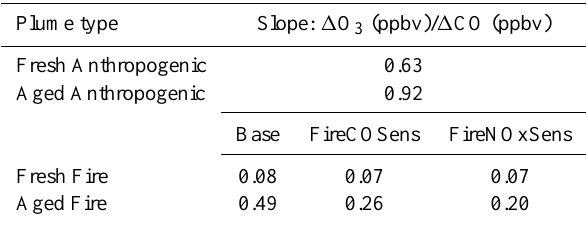
Fig. 13. The average increase in ozone ( 1 O 3 ) during the model run north of 55 ◦ N from anthropogenic plumes (a) and fire plumes (b) . Excess ozone is calculated as the average ozone increase ( 1 O 3 ) north of 55 ◦ N upon including anthropogenic (base-noAnthro) or fire (base-noFire) emissions.